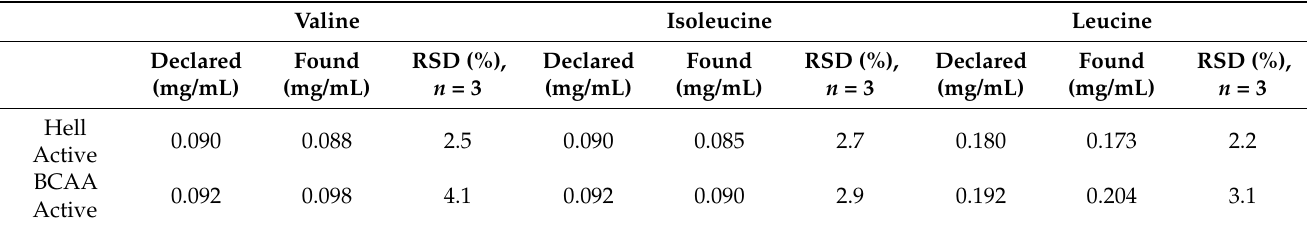
Table 10. Determined concentrations of BCAAs in tested food samples.